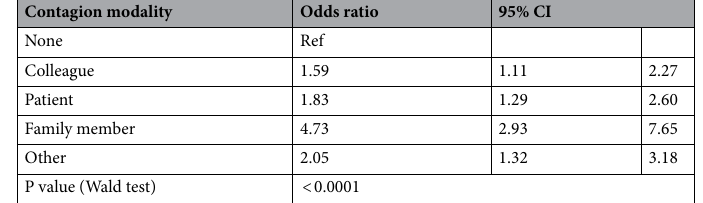
Table 5. Summary measures of association of interactions with IgG positivity. Multilevel logistic analysis, considering subjects nested in the hospital site. Adjusted for role, age (cut off = 60 years) gender, BMI, smoking